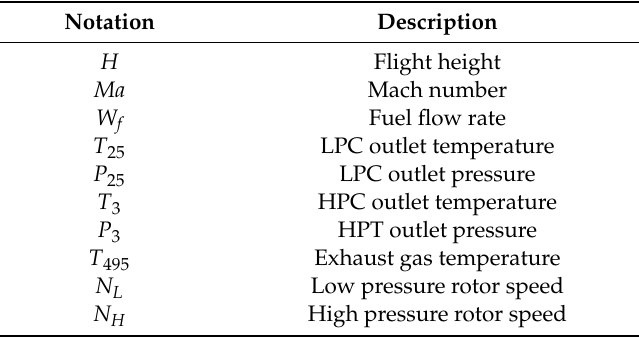
Figure 1. Structure of the engine. Table 1. The descriptions of the notations.